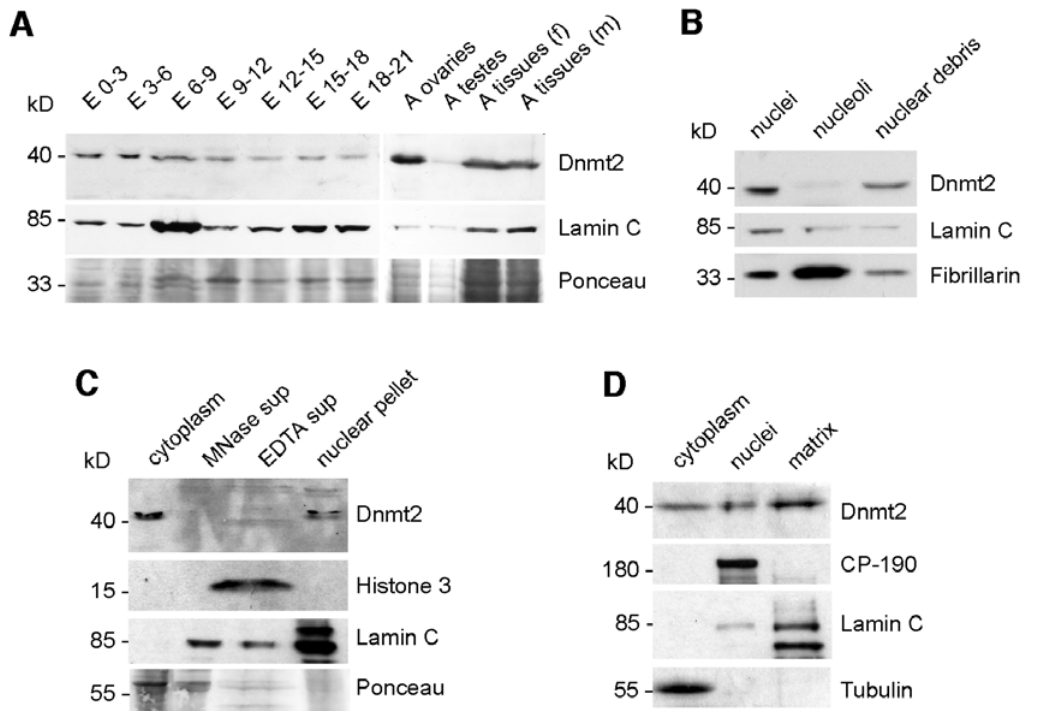
Figure 3. Dnmt2 is present in nuclei and resides in an insoluble part of the nuclear matrix. (A) Developmental Western blot. Purified nuclei from embryonic and adult tissues were urea extracted, blotted and probed with anti-Dnmt2. Ponceau staining is shown as a loading control, lamin C staining is shown as a control for the enrichment of nuclear proteins. (B) Dnmt2 is not enriched in nucleoli. Sucrose density fractionation of nucleoli followed by blotting and tracing of nucleolar material using anti-Fibrillarin shows that Dnmt2 is part of other nuclear structures. (C) Dnmt2 is not enriched in nucleosomes. Micrococcal nuclease digest of purified nuclei releases histone H3 (EDTA supernatant), but not Dnmt2. The EDTA extracted nuclei still contain Dnmt2 suggesting association of Dnmt2 with non-chromatin structures. (D) Dnmt2 is associated with the nuclear matrix. Nuclear Dnmt2 is insoluble after DNAse digest, followed by high salt extraction and can only be solublilzed using urea extraction. CP-190 is included as a peripheral and lamin C as an integral nuclear matrix interacting protein. E-embryo, A-adult, f-female, m-males, MNase-micrococcal nuclease, sup- supernatant.